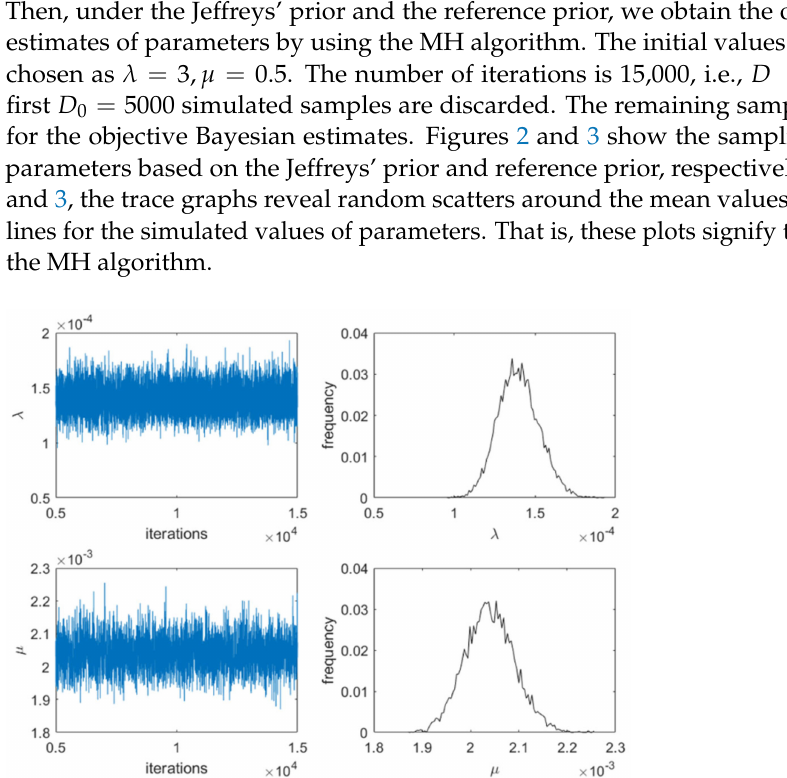
Figure 2. The sampling process of posterior distribution under the Jeffreys prior π J ( λ , µ )